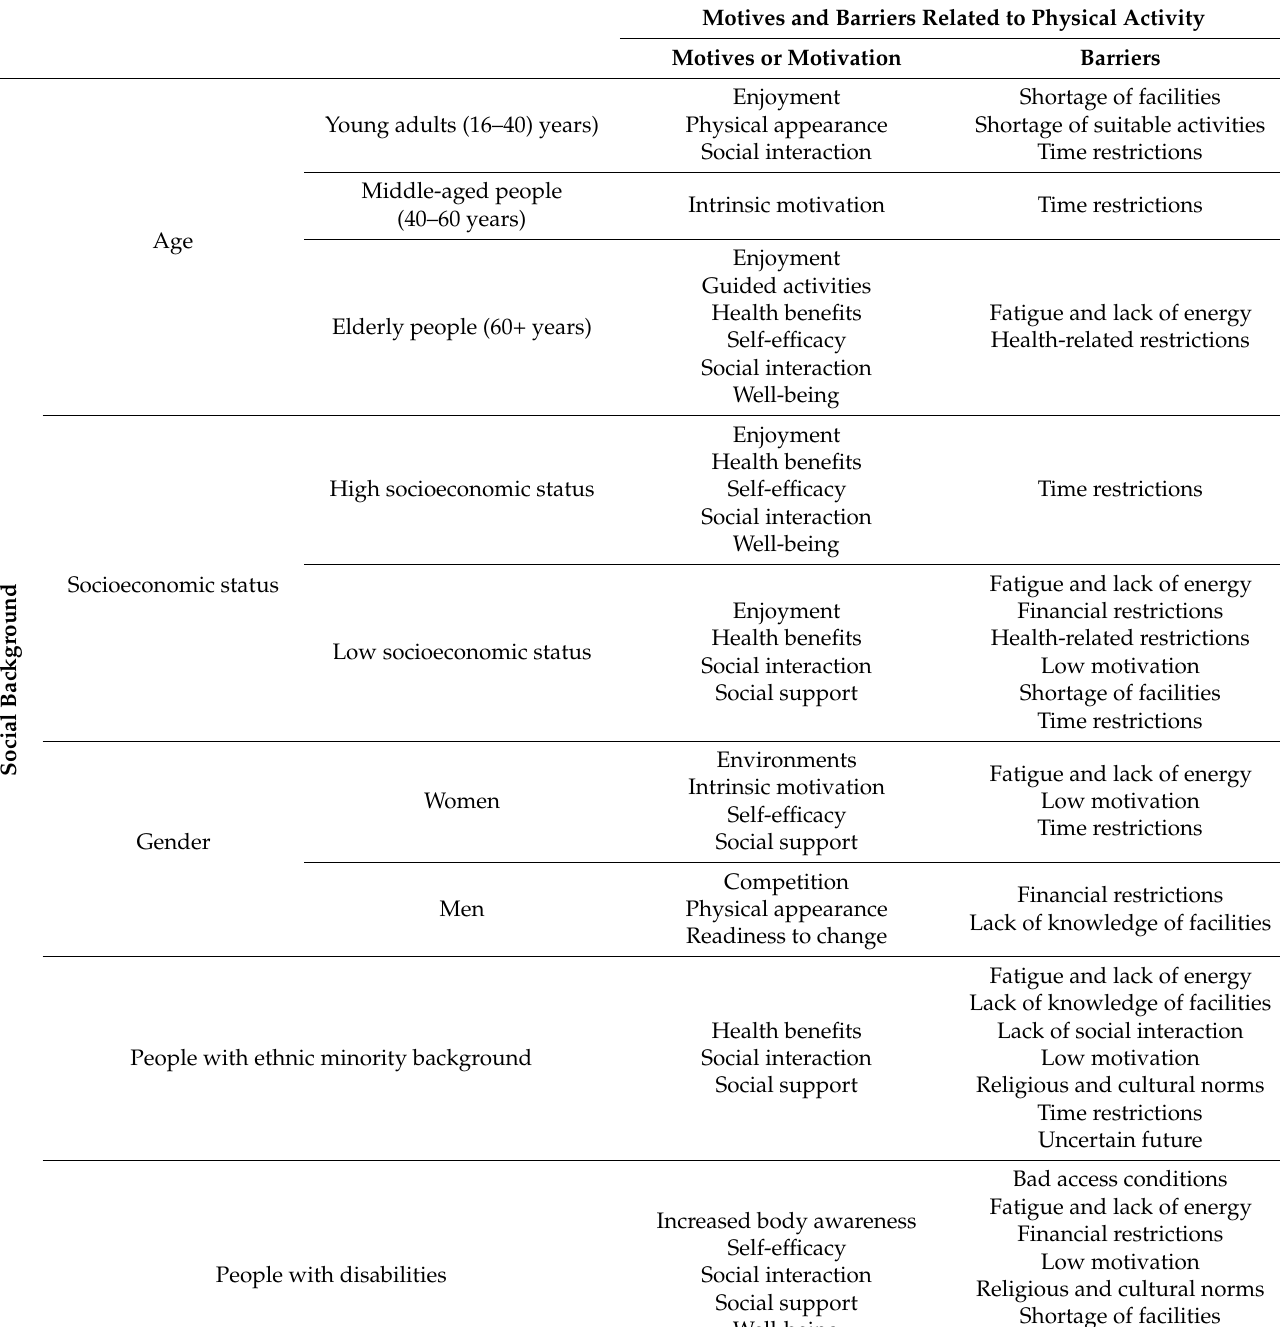
Table 4. Motives and barriers related to physical activity across social